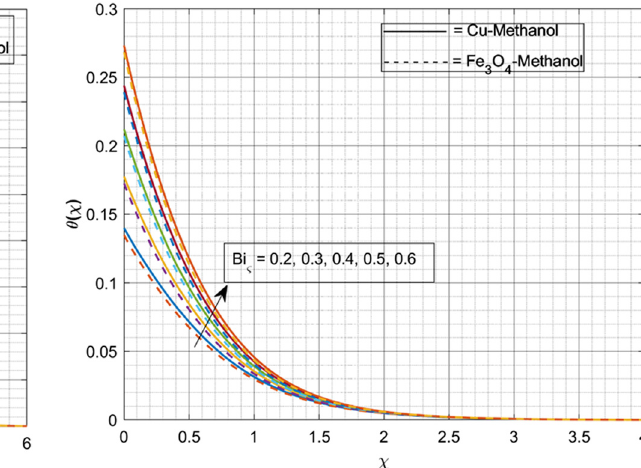
Figure 6: Sway of α on f ′ .